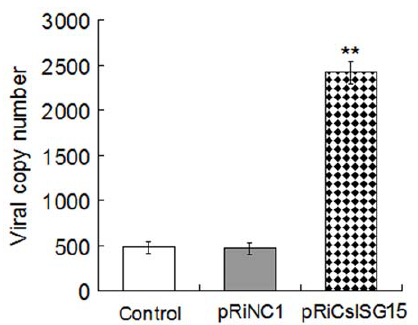
Figure 9. Effect of CsISG15 RNAi on viral infection. Tongue sole head kidney lymphocytes transfected with pRiCsISG15, pRiNC1, and pRNAT-CMV3.1 (control) were infected with megalocytivirus. Viral numbers in the cells were determined at 4 h post-infection. Data are shown as means 6 SE (N=5). N, the number of repeated experiments. Significance between RNAi and the control is indicated with asterisks. ** P ,